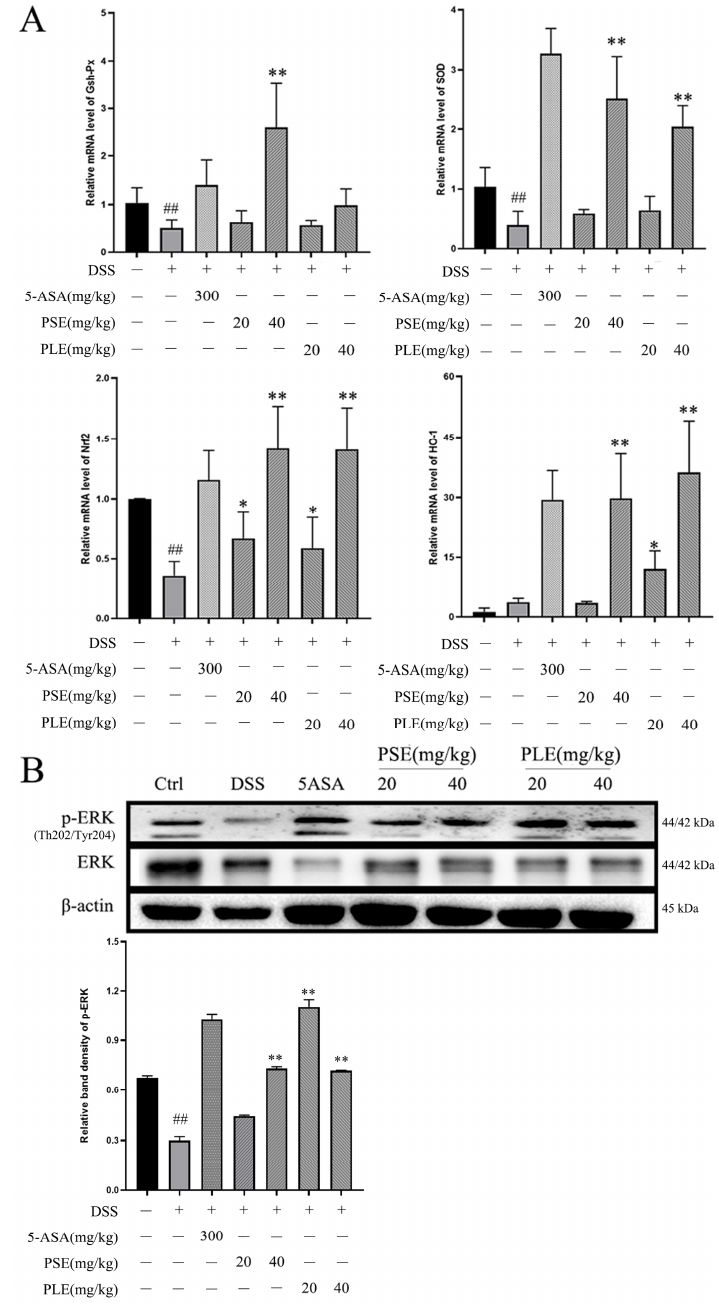
Figure 4. PSE and PLE suppressed oxidative stress by activating ERK/Nrf2 in colon of DSS induced colitis model. ( A ) The mRNA levels of gsh-px, sod, nrf2 and ho-1 were measured by Q-PCR analysis. ( B ) The protein levels of p-ERK and ERK in the colon tissue were measured by western blot analysis. Data are represented as mean ± SD of three independent experiments. The “+” indicates that the substance (3.5% DSS) was added, and the “–” indicates that the substance was not added. ## p < 0.01 vs. Control (Ctrl), * p < 0.05, ** p < 0.01 vs. model group (DSS) .